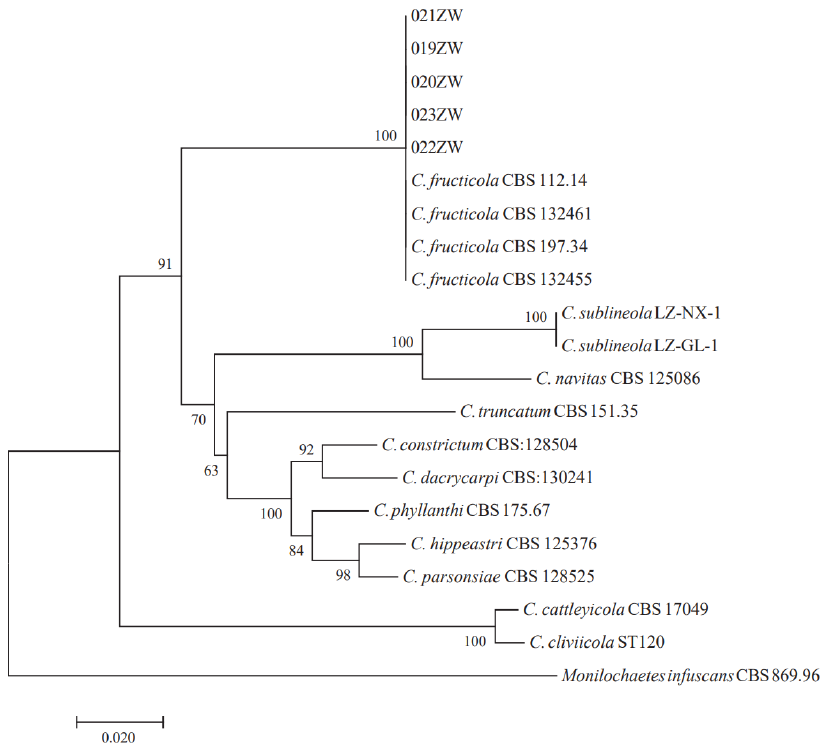
Figure 3. The ITS– GAPDH–TUB2 phylogenetic tree. 019ZW, 020ZW, 021ZW, 022ZW, 023ZW, and C. fructicola clustered together. Table 2. Reference isolates used in the present study and their GenBank accession numbers.